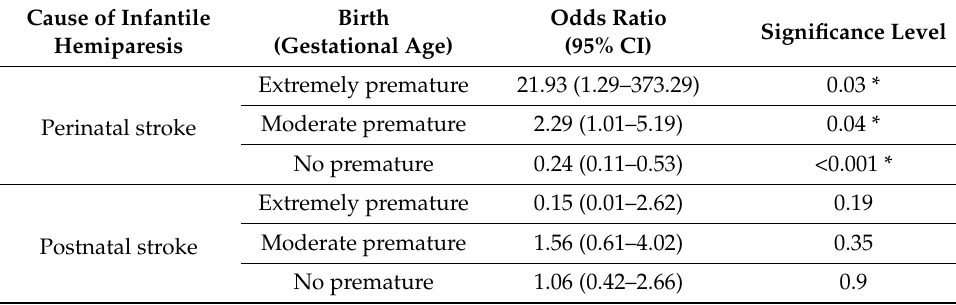
Table 4. Association between the cause of infantile hemiparesis and